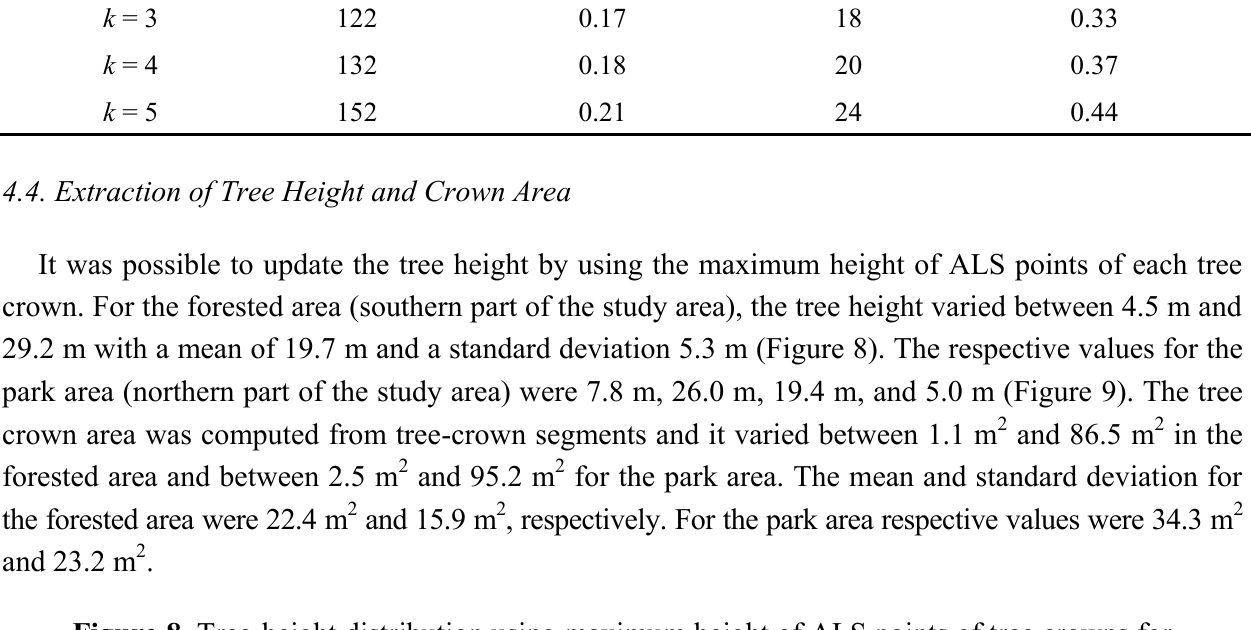
Figure 8. Tree-height distribution using maximum height of ALS points of tree crowns for the forested area (southern part of the study area).